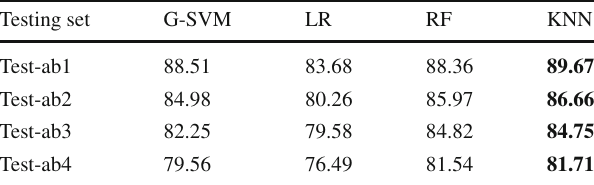
Table 10 Acc of SQI features on the four traditional classifiers Testing